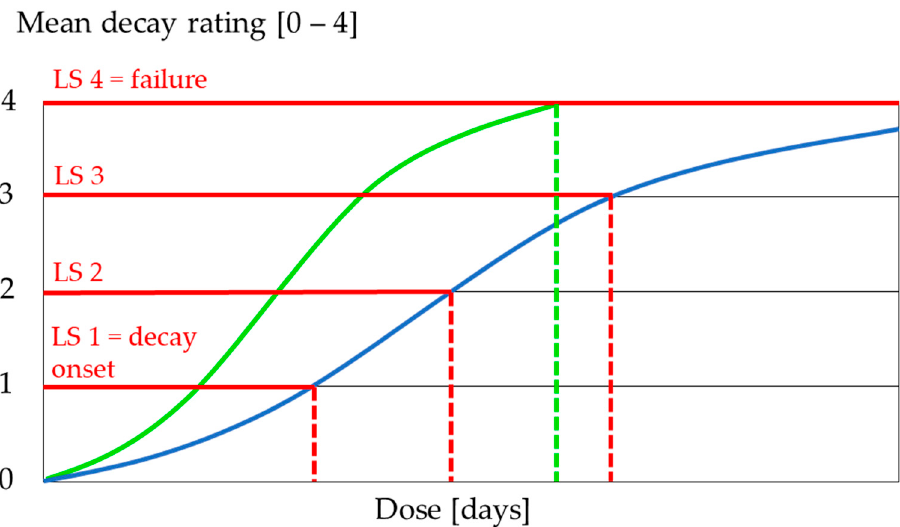
Figure 3. Example relationship between cumulative total dose measured in days and mean decay rating according to EN 252:2015 [27] for wood specimens exposed aboveground. LS = limit state; green curve = wooden element exposed in-ground; blue curve = wooden element exposed above- ground. Graph adapted from Brischke and Frühwald Hansson [28].